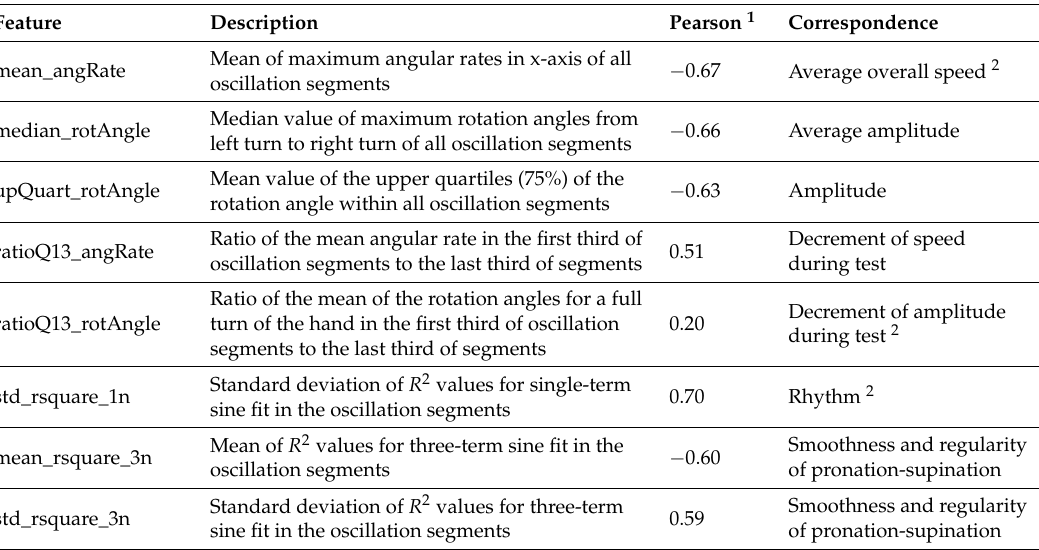
Table 3. Description of features finally used for the